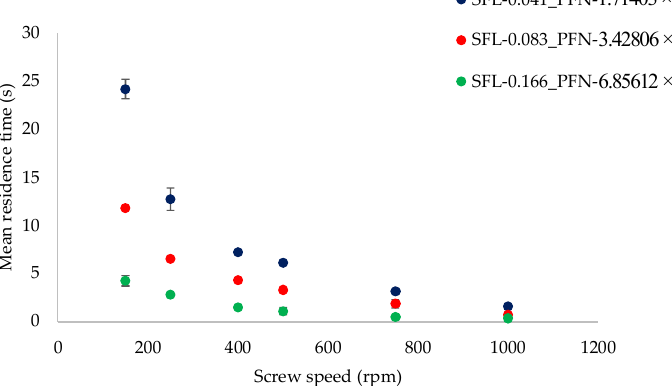
Figure 3. Mean residence time of lactose at different SFL–PFN at varying screw speed (L/S 0.1).